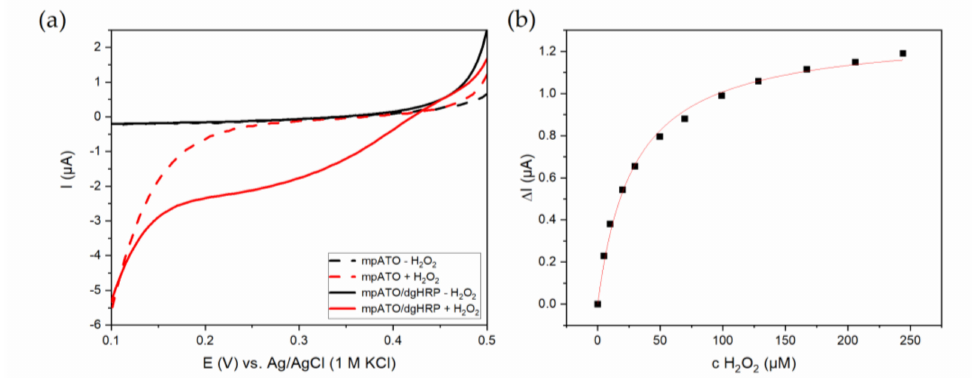
Figure 4. Electrocatalytic reduction of hydrogen peroxide by dgHRP adsorbed on mpATO. ( a ) Linear sweep voltammograms of bare (dashed lines) and dgHRP-modified (solid lines) mpATO before (black) and after (red) addition of 2 mM hydrogen peroxide in air-saturated 100 mM phosphate bu ff er, pH 7.4. Scan rate 2 mV / s, stirring speed 500 rpm. ( b ) Concentration dependent current increase of a dgHRP modified mpATO upon hydrogen peroxide addition obtained from amperometric measurements at 0.2 V vs. Ag / AgCl. Data were fit to the Michaelis–Menten equation. Adapted from